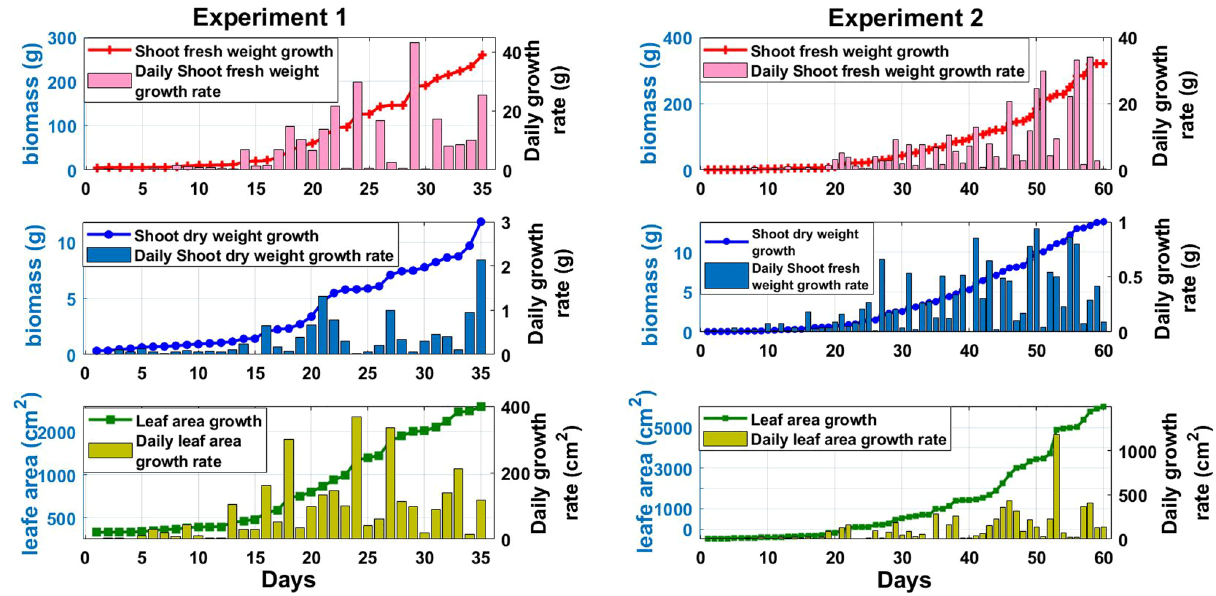
Figure 4. The overall growth performance and the daily growth rate responses of lettuce dry and fresh weights and leave area during experiment 1 and